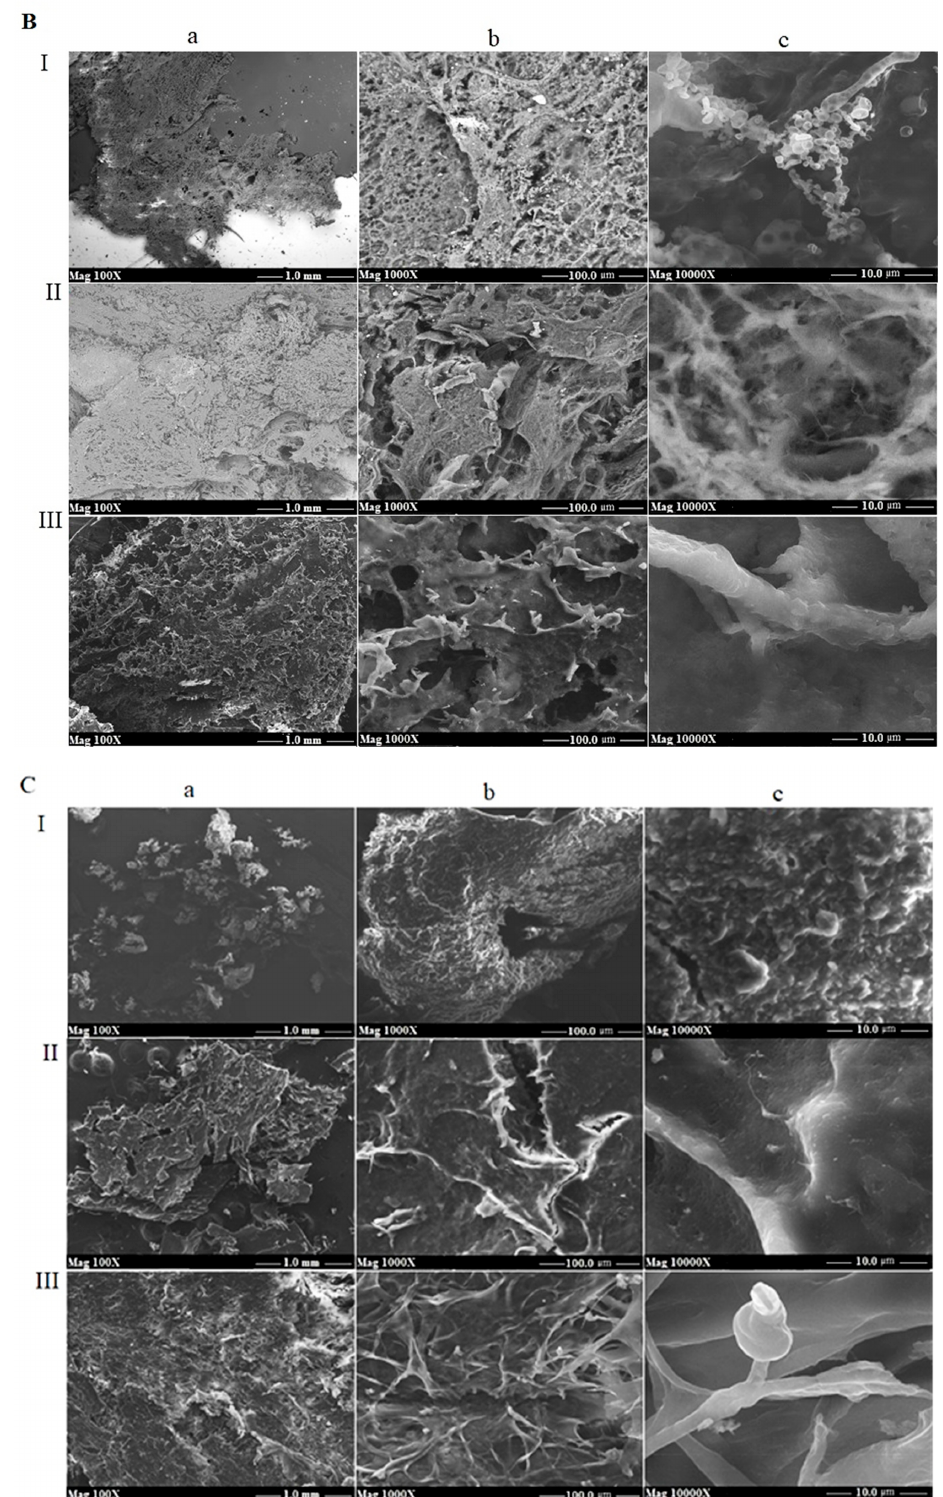
Figure 7. Scanning electron images of cow ( A ), buffalo ( B ), and goat ( C ) kefirans, extracted with cold water (I), hot water (II), and mild heat ‐ ultrasound (III) at three different magnifications and scales: a (100X, 1.0 μ m); b (1000X, 100.0 μ m); c (10,000X, 10.0 μ m).